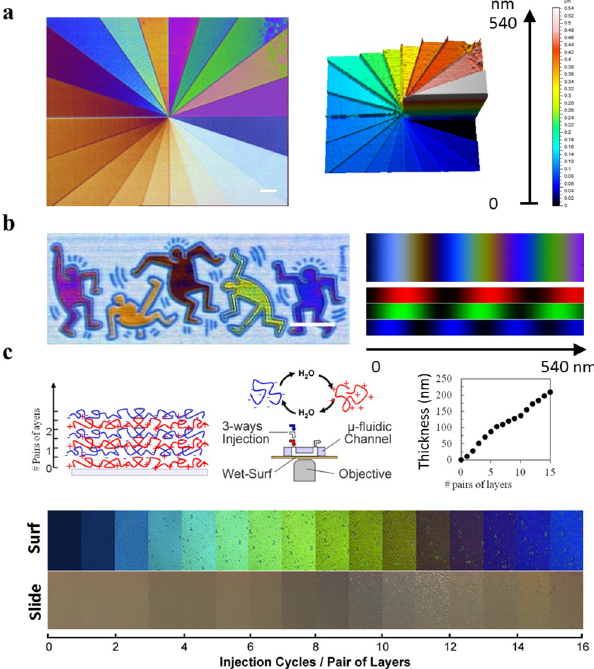
Fig 3. Mesoscopic measurement and imaging of dense and hydrated thin films. (a) Wet-SEEC image (left) and 3D Topography reconstruction based on Wet-SEEC image of a nanofabricated scale of steps 20–30 nm linking the nanoscopic and mesoscopic measurement capabilities. Scale bar 10 μ m. (b) Raw Wet-SEEC image of a nanofabricated sample (inspired from a Keith Haring painting) composed of characters of different thickness within the mesoscopic range. The tint in the Wet-SEEC image can be directly linked to a corresponding thickness using the theoretical tint scale (right). Scale bar 10 μ m. (c) Schematics of the automatized layer by layer polyelectrolyte (LbL) deposition in a coupled microfluidics/Wet-SEEC device (Top-left). Sequence of images versus number of deposited pairs of layers of poly(allylamine), PAH, and polystyrene sulfonate, PSS, taken on a wet-surf and on a glass microslide (Bottom). Thickness of the polyelectrolyte multilayer measured by the Wet-SEEC technique versus the number of polyelectrolyte layers (Top-right). Error bars ± 3 nm. Polyelectrolyte solutions were made at 0.5%wt with 1 M of NaCl and adjusted to pH = 2 for PAH. (See also S1